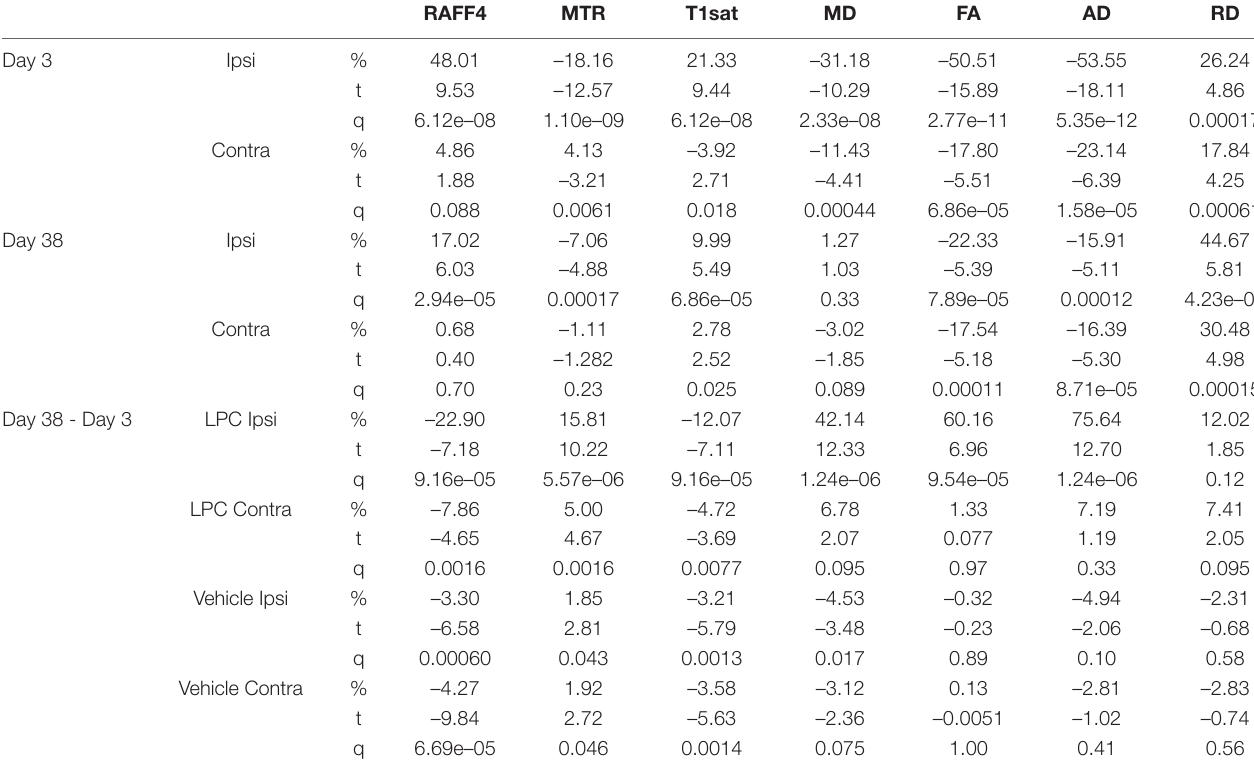
TABLE 1 | Relative differences with statistical significances in the MRI